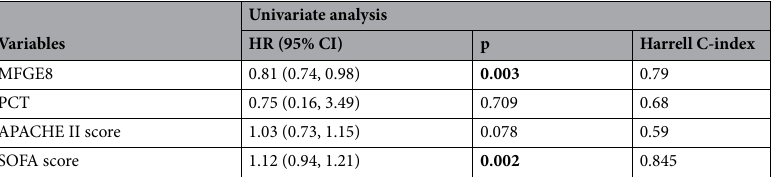
Table 2. Associations between each variable and mortality. We used Cox’s proportional hazard model to evaluate associations between each variable and mortality. MFGE8 milk fat globule epidermal growth factor 8, PCT procalcitonin, APACHE Acute Physiology and Chronic Evaluation, SOFA Sequential Organ Failure Assessment, HR hazard ratio, CI confidence interval. Significant values are in bold.